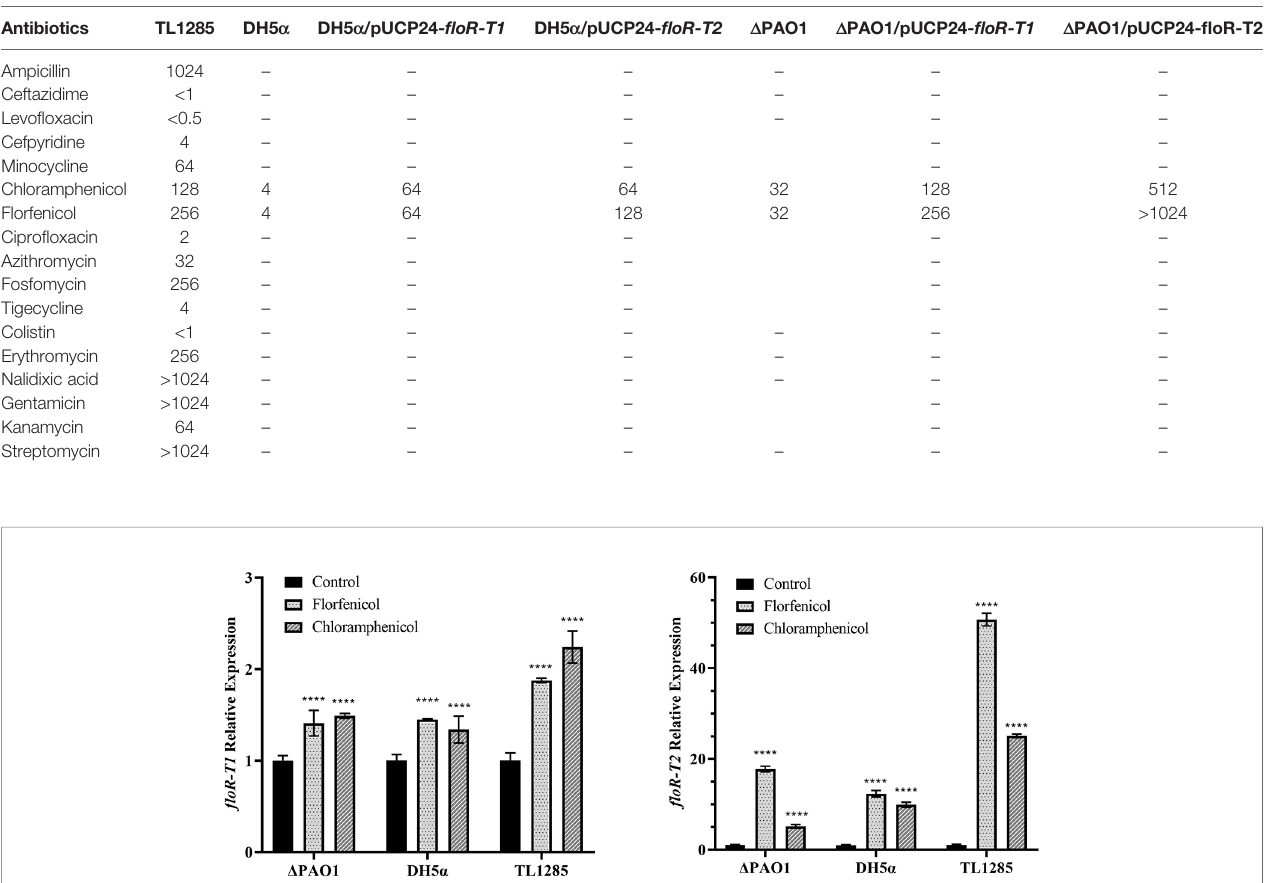
TABLE 3 | MIC results of P. aeruginosa TL1285 and recombinants to 17 antibiotics ( m g/mL).